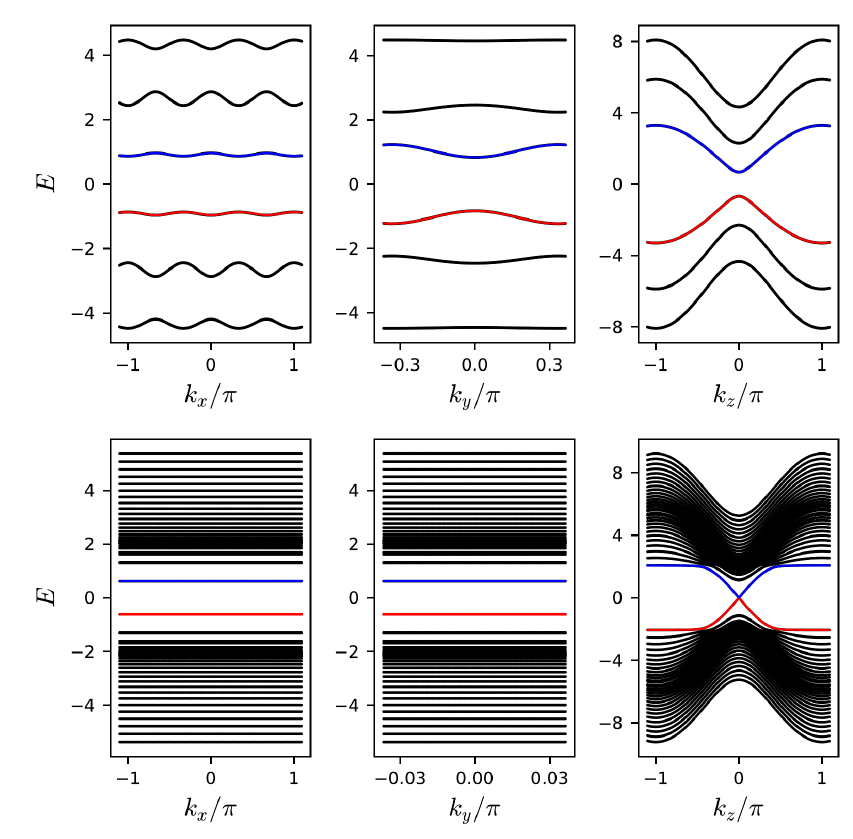
Figure 10: The bulk energy spectrum in k , k and k directions for q = 3 (first x y z = 0.9, at the row) and q = 30 (second row). The parameters are M = 1.8, t x location of the point p in the phase diagram Fig. 8. For each of the plots, one of the 1 = 0.3 π , k = 0.2 π/ q momenta is allowed to vary, and the other ones are fixed at k x y = 0.1 π appropriately. The two central bands are shown in color. Note that and k z the dispersions in k and k become almost flat for q = 30. Also, the low energy x y dispersion as a function of k for q = 30, has a very tiny gap, explained further in the z